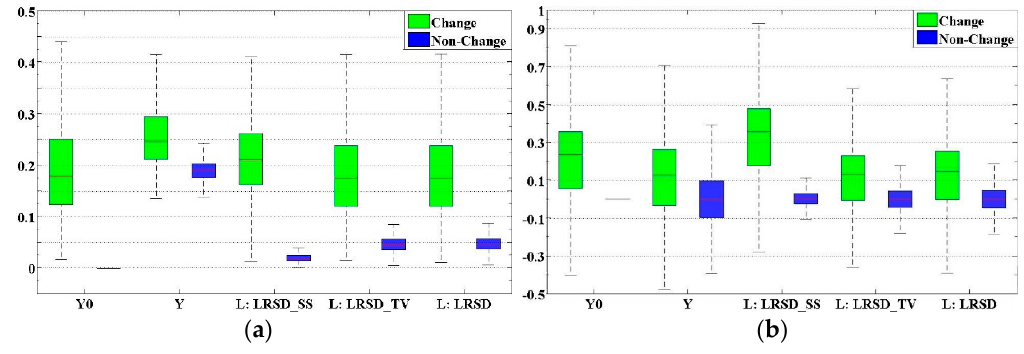
Figure 9. In an exemplary case of Data 10, box plots of: ( a ) spectral amplitudes of all the samples in Y , Y , Y 0 and L produced by LRSD_SS/ LRSD_TV/ LRSD; and ( b ) spectral values of these samples in band 92. On each box, the central mark represents the median, the edges are the 25th and the 75th percentiles, and the whiskers extend to the most extreme data points not considered as “outliers” defined by function “boxplot” in MATLAB 2013b (these “outliers” are not the same as those defined by LRSD, except for the name). The maximum whisker length is 1.5.